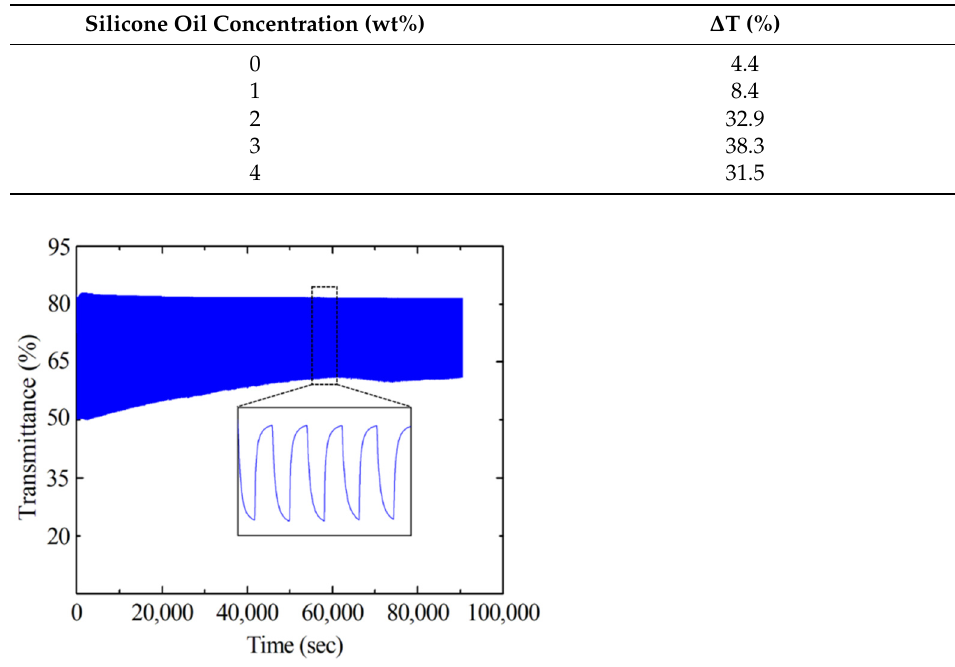
Table 3. Transmittance modulation of the EC device at 550 nm for different silicon oil concentrations.